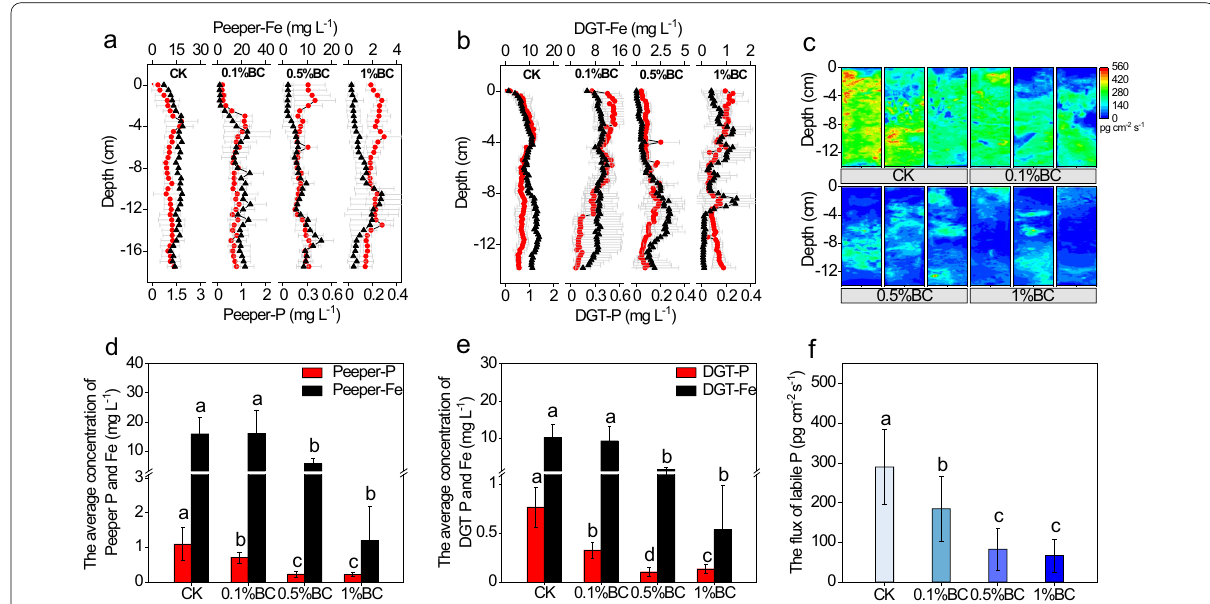
Fig. 1 Variation of Peeper-P/Fe (soluble P/Fe) ( a ), DGT-P/Fe (labile P/Fe) concentrations ( b ), and labile P flux ( c ) measured by HR-Peeper, 1D-DGT, and 2D-DGT in the paddy soil around rice roots at rice seedling stage under four biochar treatments in-situ under field experiments . The average concentrations of Peeper-P/Fe ( d ), DGT-P/Fe ( e ), and labile P flux ( f ) for three replicate depth profiles were calculated. CK, 0.1%BC, 0.5%BC, and 1%BC are referred as biochar addition rates at 0, 2.25, 11.25, and 22.5 t ha − 1 , respectively. Error bars represent the standard deviations of the mean ( n